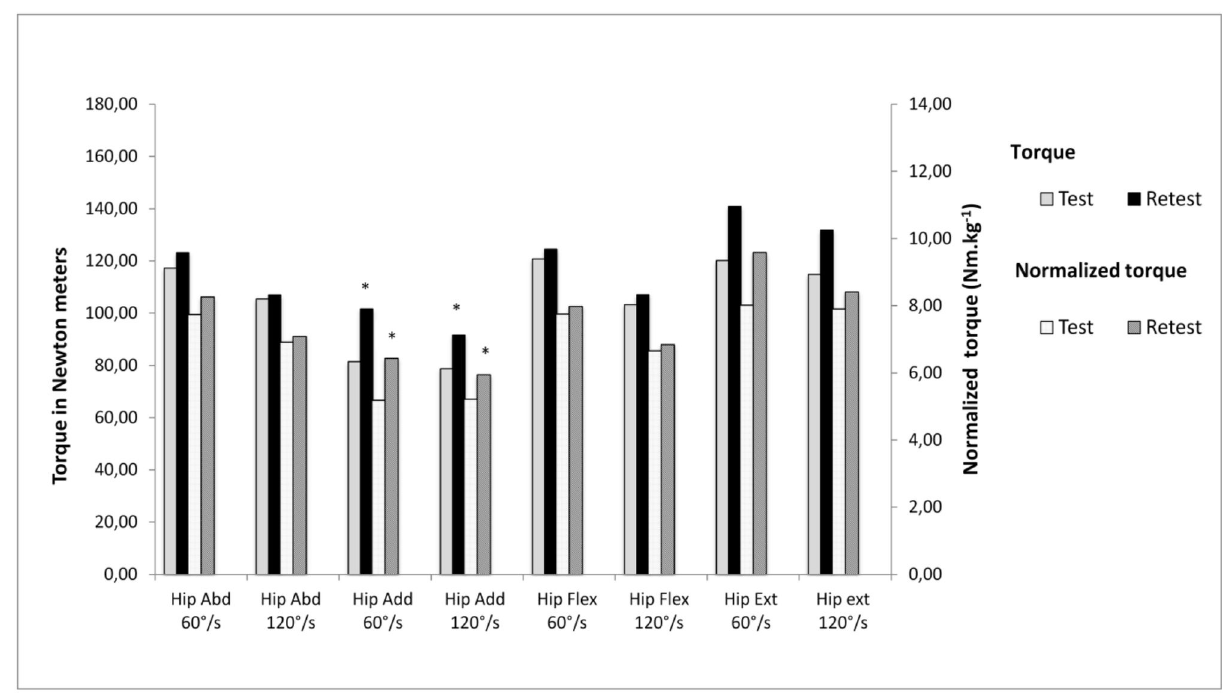
Figure 2. Mean peak test-retest of isokinetic peak torque expressed in relative and normalized value. *p<0.05 , retest significantly different from test using Wilcoxon signed rank test.